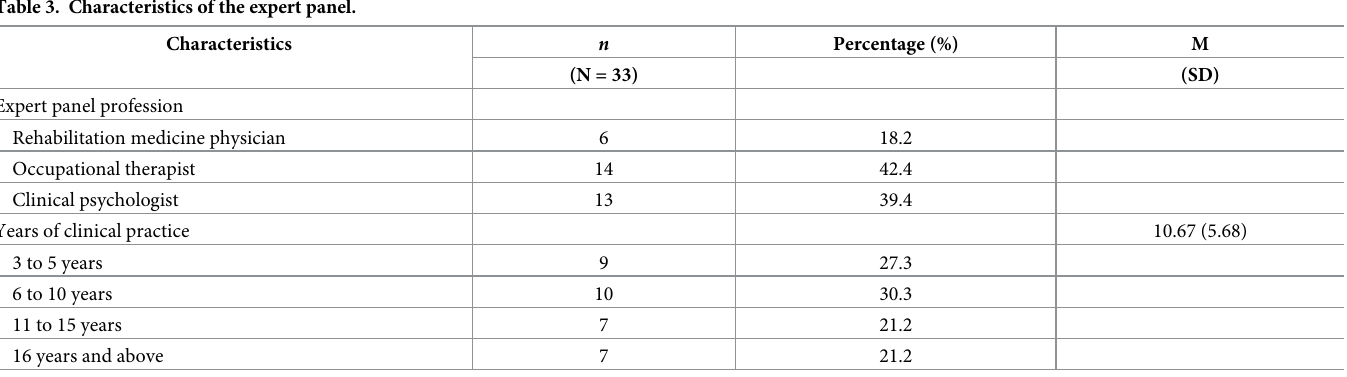
Table 3. Characteristics of the expert